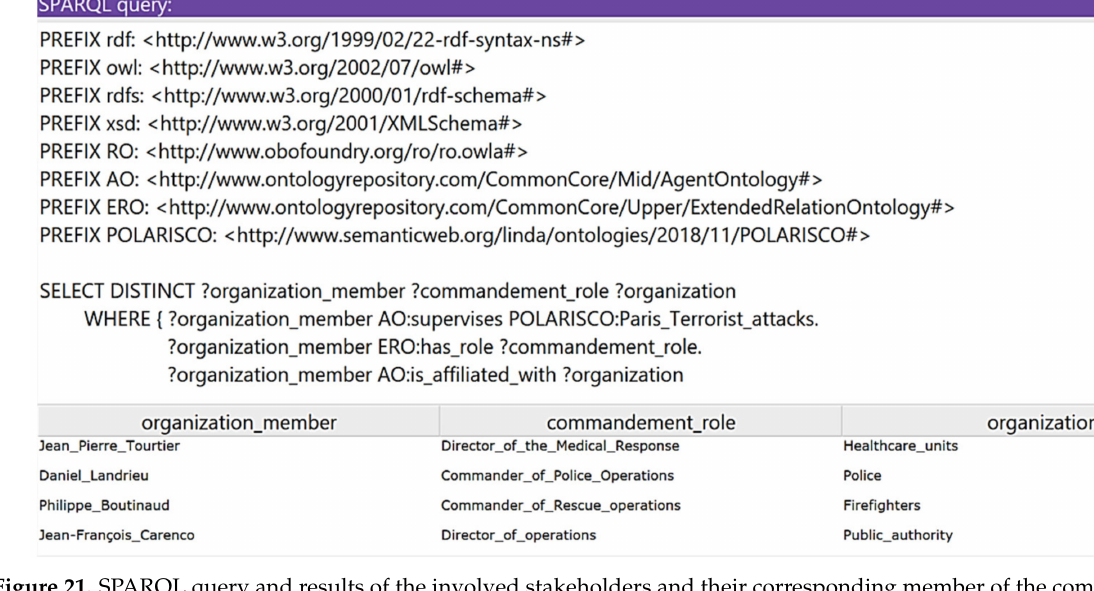
Figure 21. SPARQL query and results of the involved stakeholders and their corresponding member of the